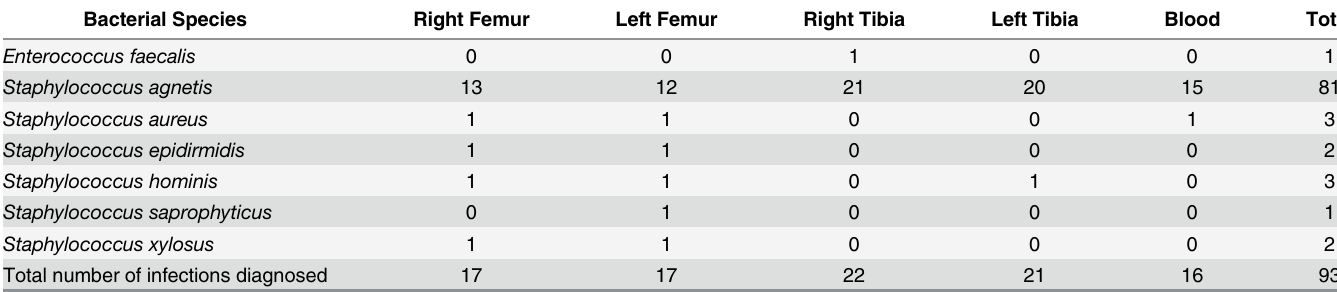
Table 1. Bacterial species from lame birds based on site